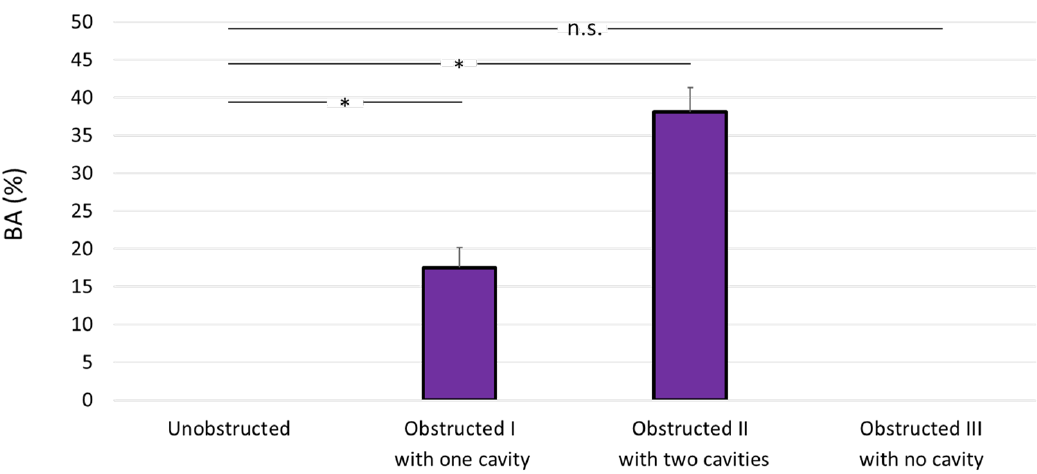
Figure 3. Bacterial attachment directly correlates with the number of cavities. The bacterial coverage area (BA) was calculated by analysis of crystal violet images, considering the entire channel volume of the chip for all designs. The unobstructed and “obstructed III with no cavity” designs show null coverage area, whereas the obstructed I and obstructed II designs show an average value of 17.5% ± 2.6% and 38.1% ± 3.2%, respectively. Data are reported as average ± standard deviation ( n = 3). Note: * p < 0.05.